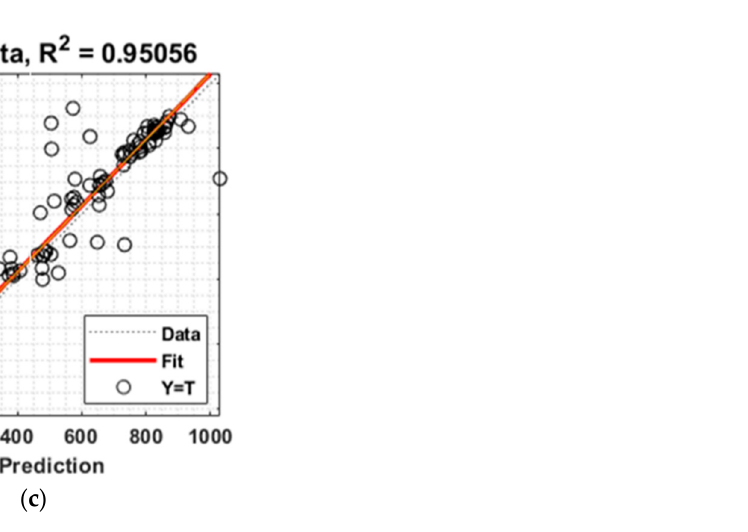
Figure 10. ( a ) The observed and predicted results, ( b ) error metrics and ( c ) regression plot considering POA—Sweihan photovoltaic independent power project, Abu Dhabi, for LSTM.